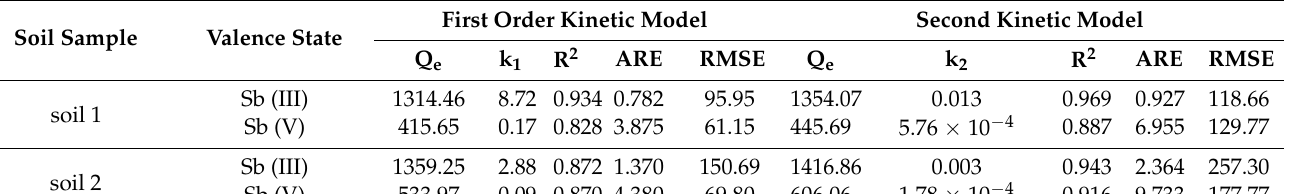
Table 2. Sb (III) and Sb (V) adsorption kinetic model parameters.